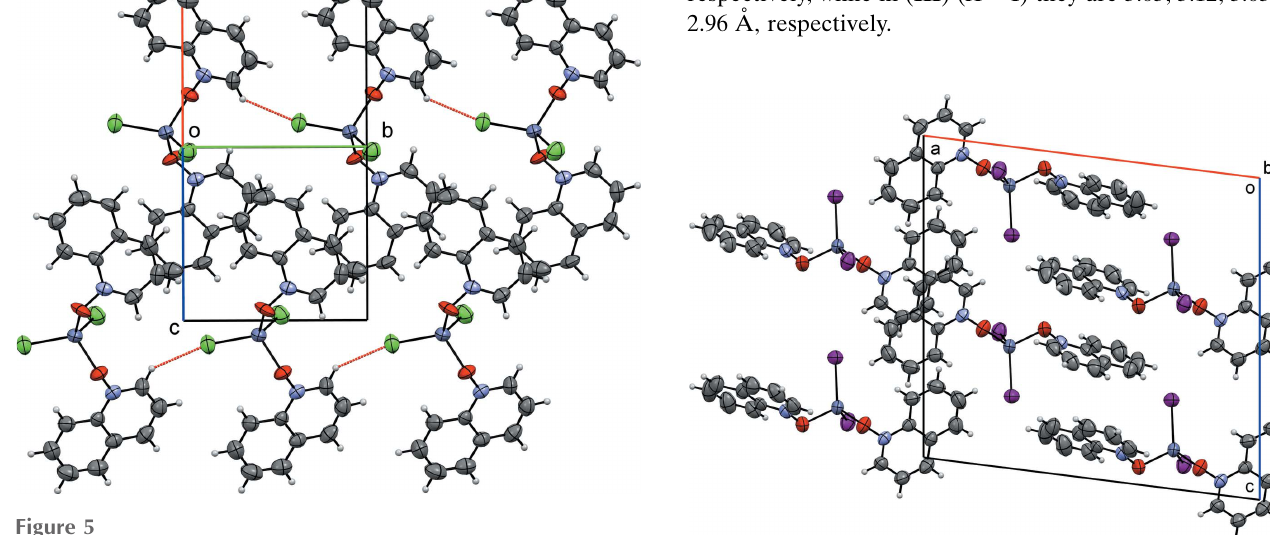
Figure 7 Crystal packing diagram of compound ( III ), viewed down the b axis.